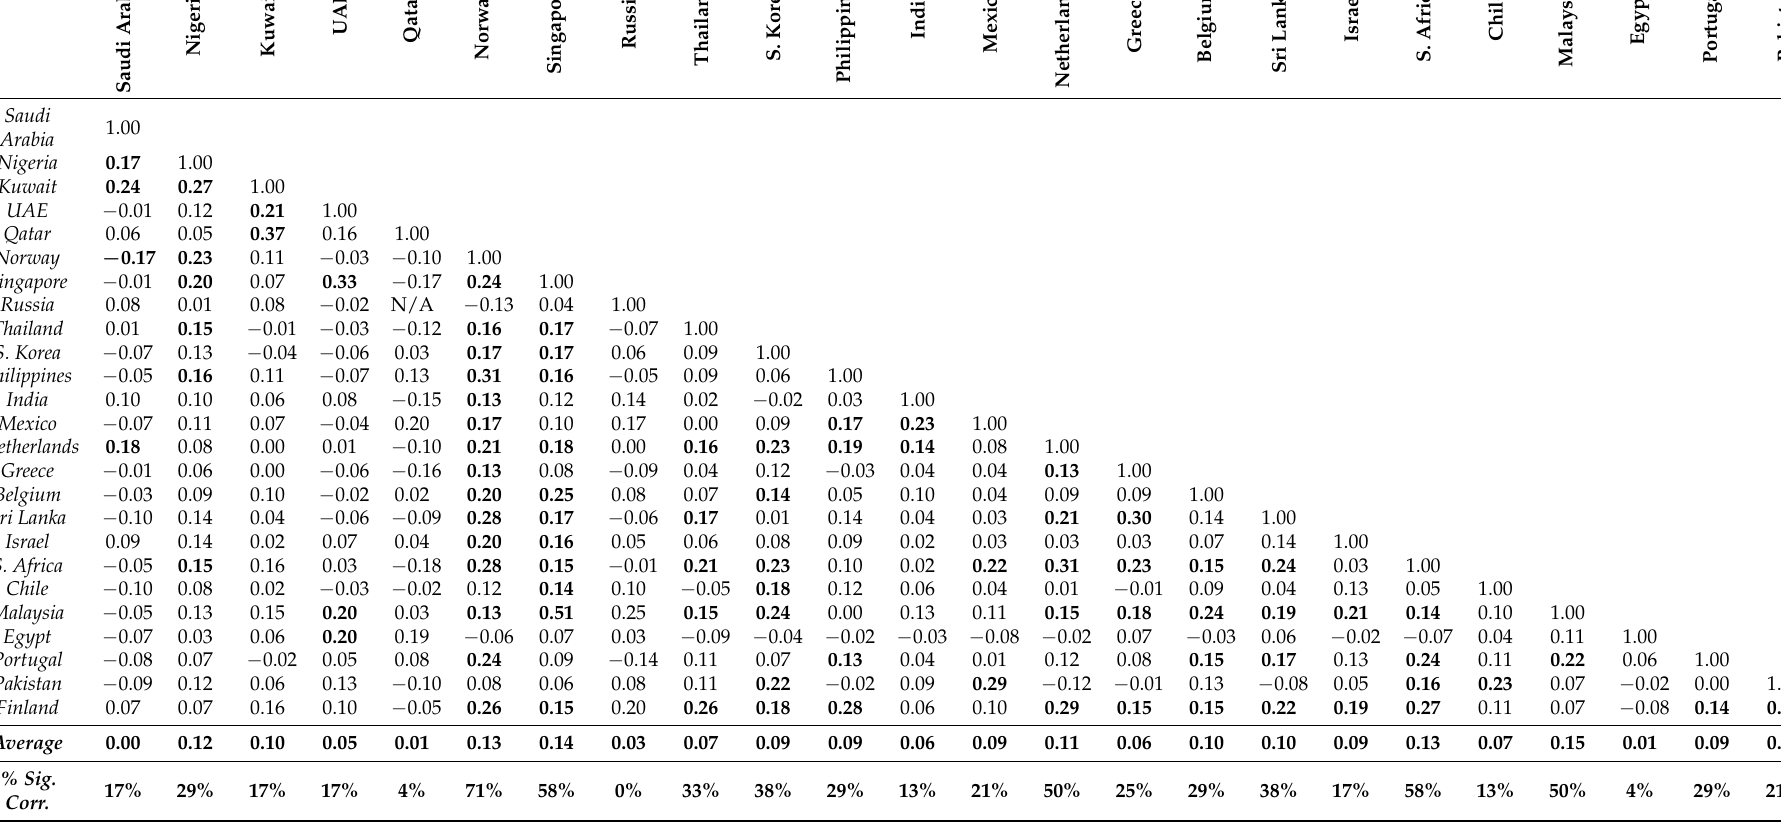
Table 3. Pairwise Correlation Coefficients. Panel A: This table reports the pairwise correlation coefficients of the commonality in liquidity measure ( R 2 highly oil-sensitive group. Panel B: This table reports the pairwise correlation coefficients of the commonality in liquidity measure ( R 2 and the less oil-sensitive groups. Bold font refers to a statistical significance at the 1%